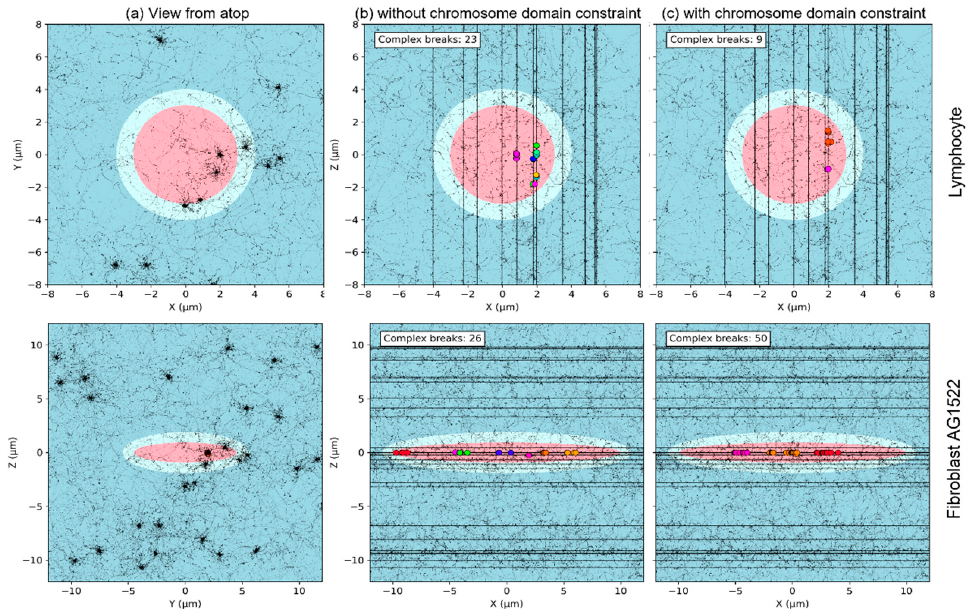
Figure 14. Projected track structure (black dots and lines) and complex DSBs (colored circles) before repair, for a Si 170 MeV/n Si irradiation (LET 99 keV/ µ m) and dose of 0.5 Gy. Views are shown from ( a ) atop the beam line and ( b , c ) side. The disks represent the cell nucleus (pink) and cytoplasm (cyan), embedded in water (blue). Results are shown for a spherical radius of radius equal to 3 µ m (top) or an ellipsoidal AG1522 fibroblast, ( b ) without chromosome domain constraint and ( c ) with chromosome domain constraint. The different colors of the DSBs represent distinct